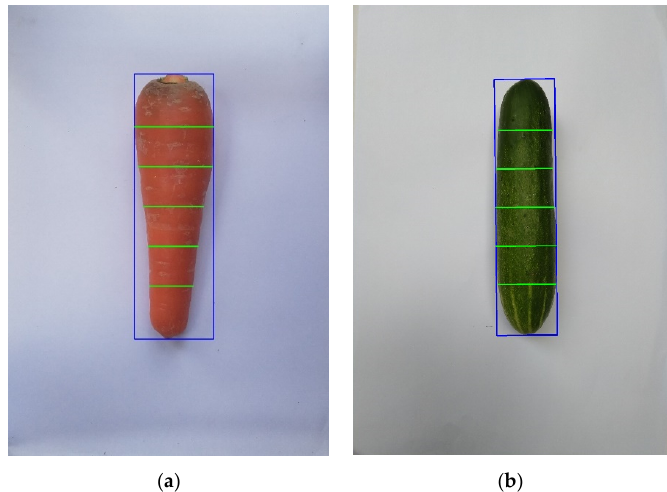
Figure 13. An example of a fruit or vegetable is sliced into six green equal slices: ( a ) carrot and ( b ) cucumber.